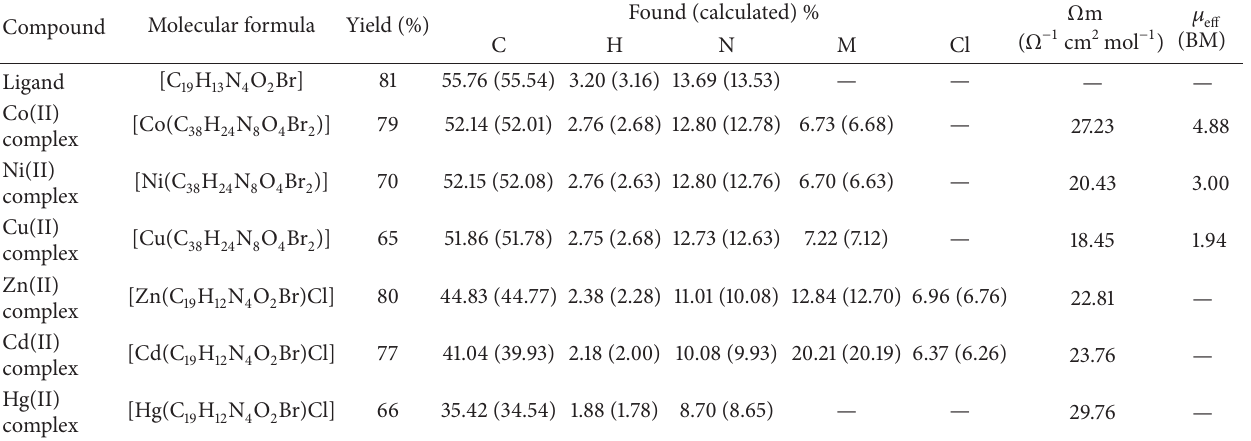
Table 2: Physical and analytical data of the ligand (BHMQMHI) and its metal (II)